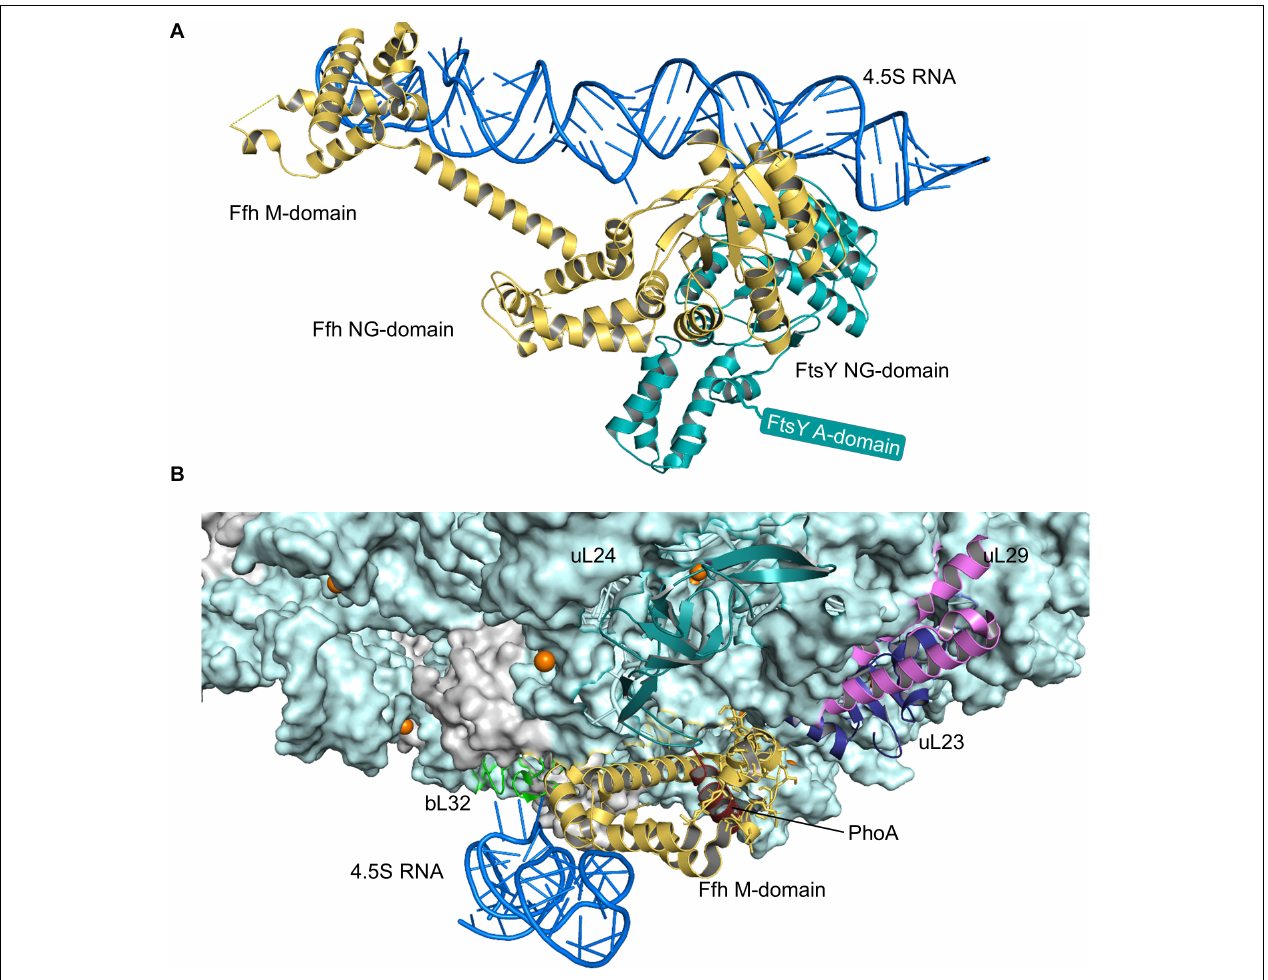
FIGURE 4 | Structures of the SRP-FtsY-complex and the SRP-ribosome complex. (A) Structure of the E. coli SRP-FtsY complex (PDB 2XXA) (Ataide et al., 2011). Ffh, the protein component of the bacterial SRP is shown in yellow and the 4.5S RNA in dark-blue. The domains of Ffh are indicated. The NG-domain of FtsY is shown in green; the structure of the N-terminal A-domain of FtsY has not been solved yet and is shown as green box. (B) Structure of an SRP-RNC complex (PDB 5GAH). The 50S ribosomal subunit is shown in light-blue and the ribosomal proteins that provide the contact site for SRP are indicated, uL23 (blue), uL29 (pink), uL24 (green), and bL32 (light-green). Ffh is shown in yellow and the 4.5S RNA in dark-blue. The nascent PhoA chain is shown in dark